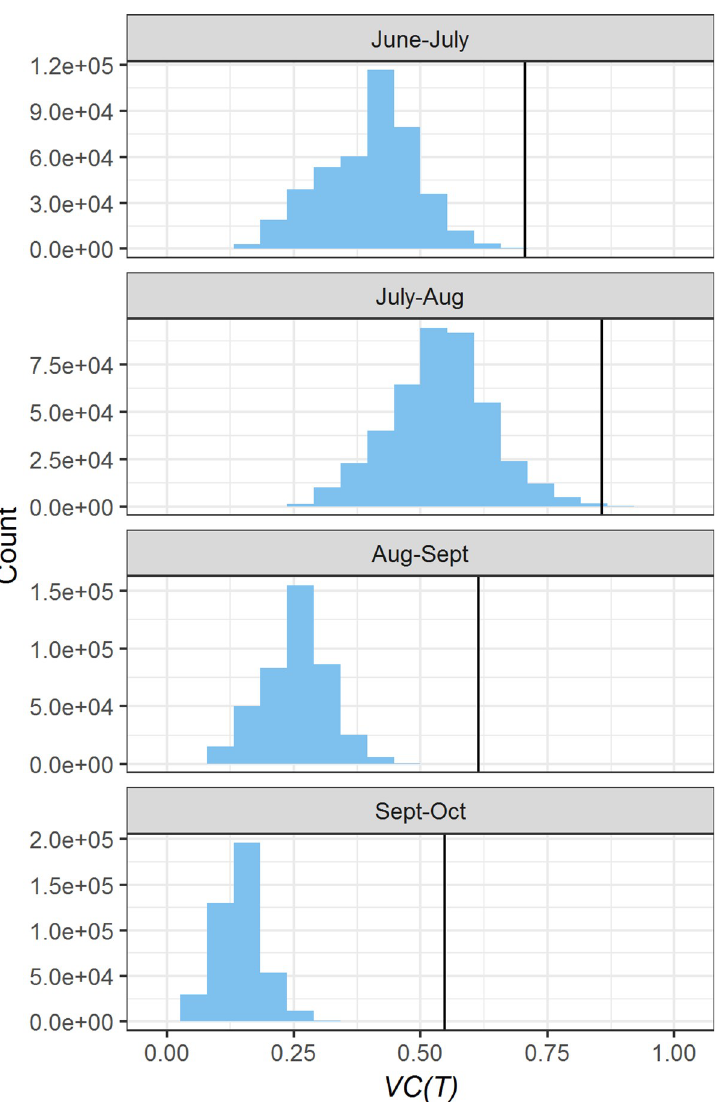
Fig 6. Histograms of temperature-dependent vectorial capacity ( VC(T) ) for Athens, GA during four monthly periods in 2018. Bars represent the distribution of VC(T) throughout the entire study area based on a sample of one million grid cells. Black lines represent point estimates of VC(T) based on data from the UGA weather station.